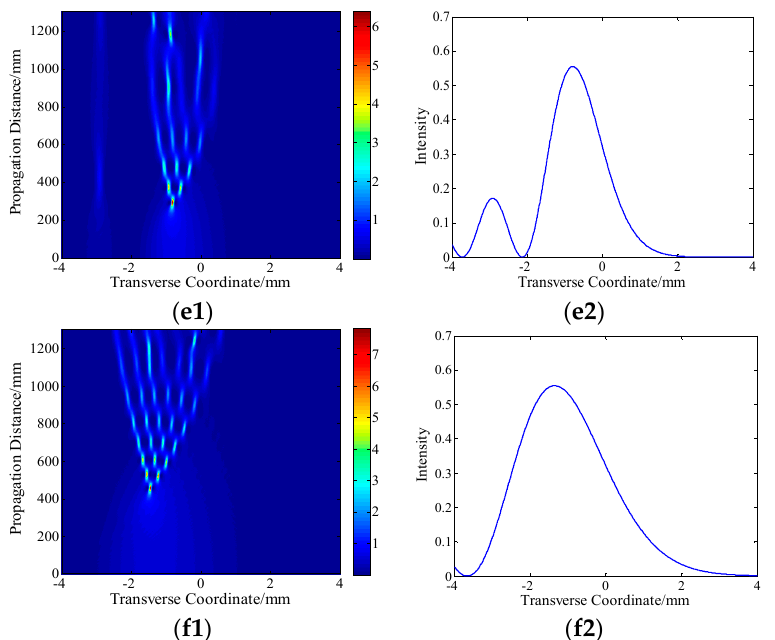
Figure 3. The propagation property of a 1D Airy beam in Kerr media with different distribution factors: ( a1 ) 𝜒 (cid:2868) = 0.5 ; ( b1 ) 𝜒 (cid:2868) = 1.5 ; ( c1 ) 𝜒 (cid:2868) = 2.2 ; ( d1 ) 𝜒 (cid:2868) = 2.9 ; ( e1 ) 𝜒 (cid:2868) = 7 ; ( f1 ) 𝜒 (cid:2868) = 12 ; and ( a2 – f2 ) are the corresponding initial intensity distri- butions for ( a1 – f1 ).